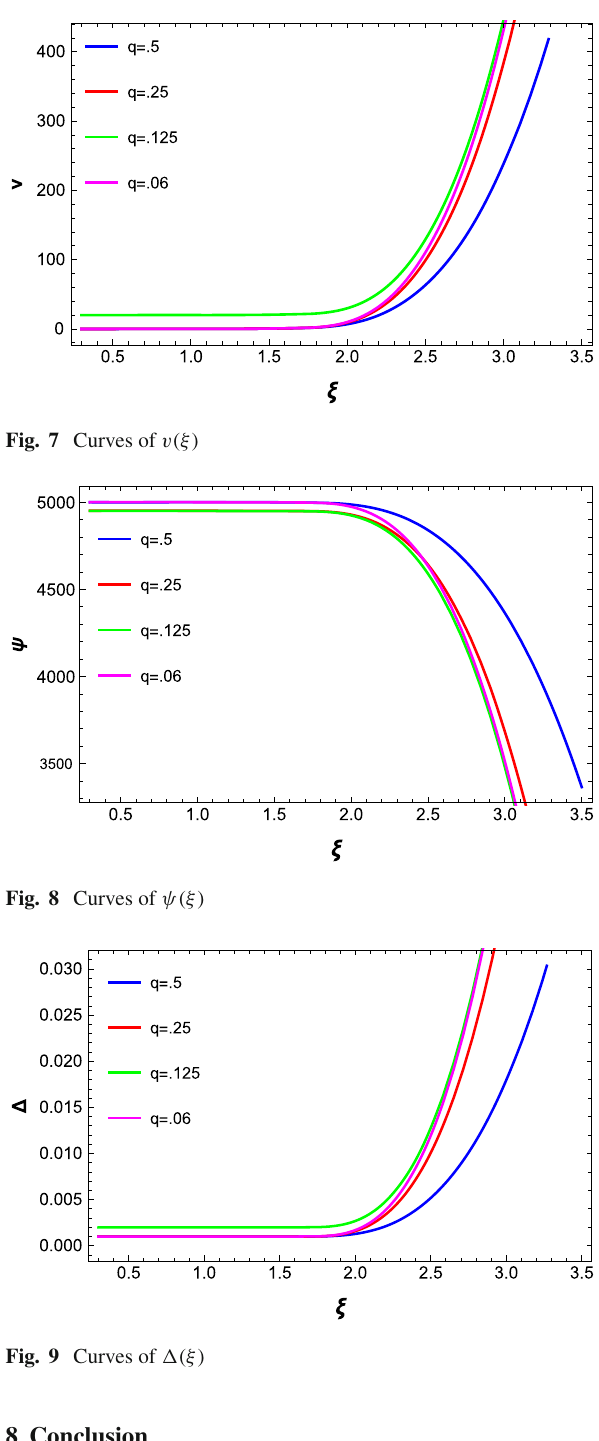
Fig. 9 Curves of